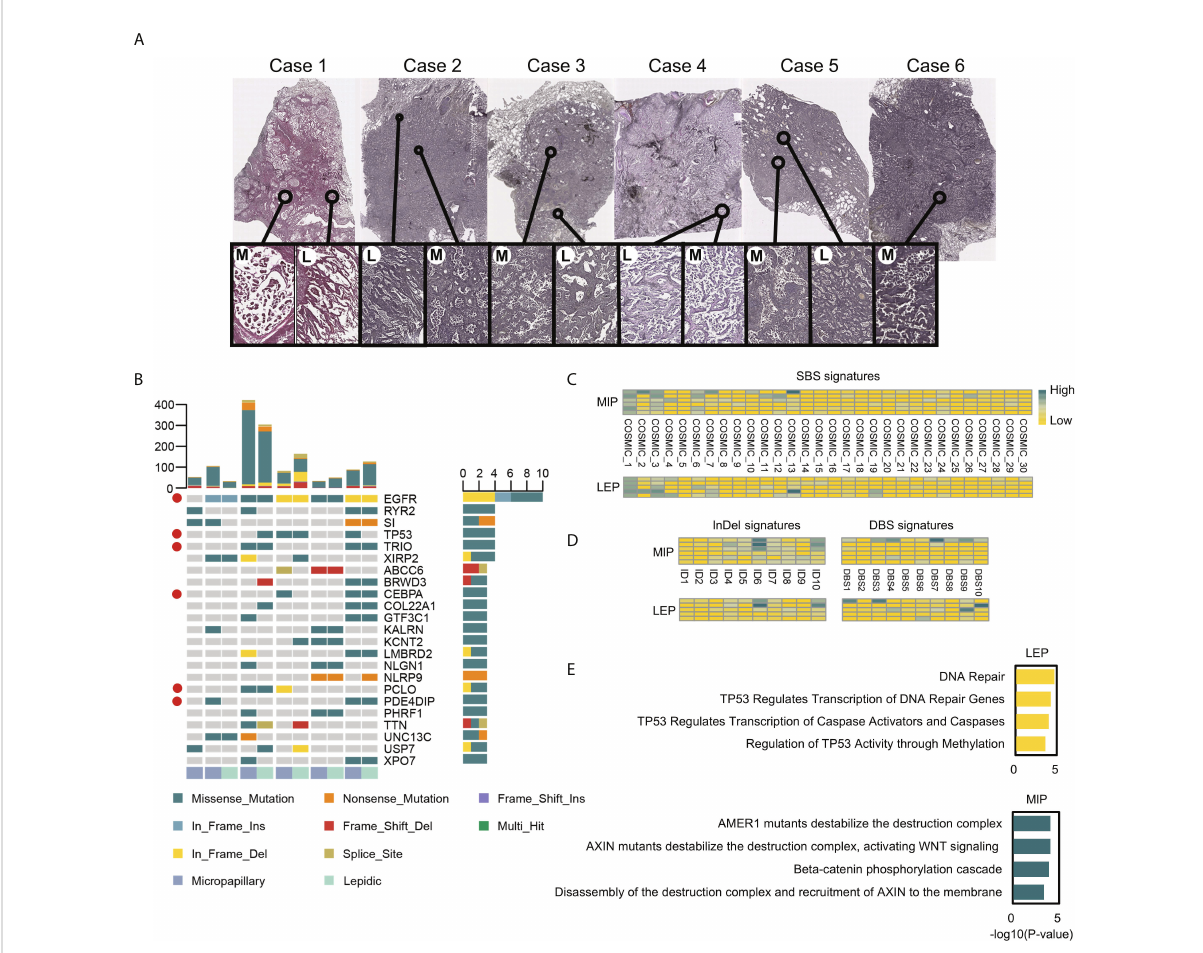
FIGURE 1 The H&E stained slides and the mutational landscape of MIP and LEP subtypes. (A) Scanner view (magni fi cation ×20) of the H&E-stained MIP (M) and LEP (L) subtypes from six patients. (B) Genes with top mutation frequency in samples. Cancer-associated genes were marked with red circles. (C) Quanti fi cations of the SBS signatures in two histological subtypes. (D) Quanti fi cations on the InDel and DBS signatures in subtypes. (E) Pathways enriched in mutated tumor suppressor genes (TSGs) for LEP and MIP